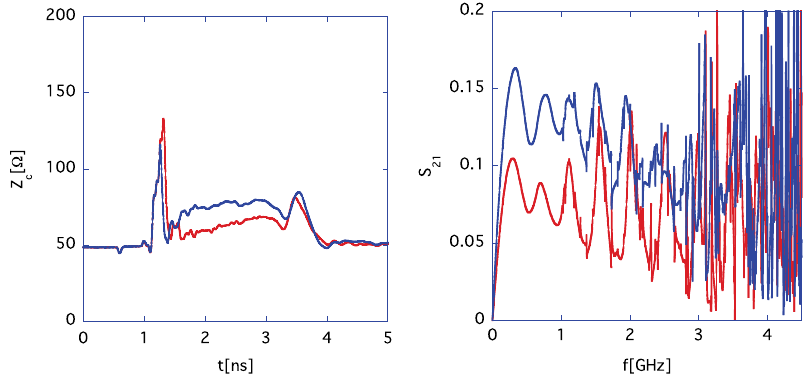
FIG. 20. The measured results of TDR (left) for the triangle electrode with (blue) and without (red) apron. The measured S 21 (right) with (blue) and without (red) apron.